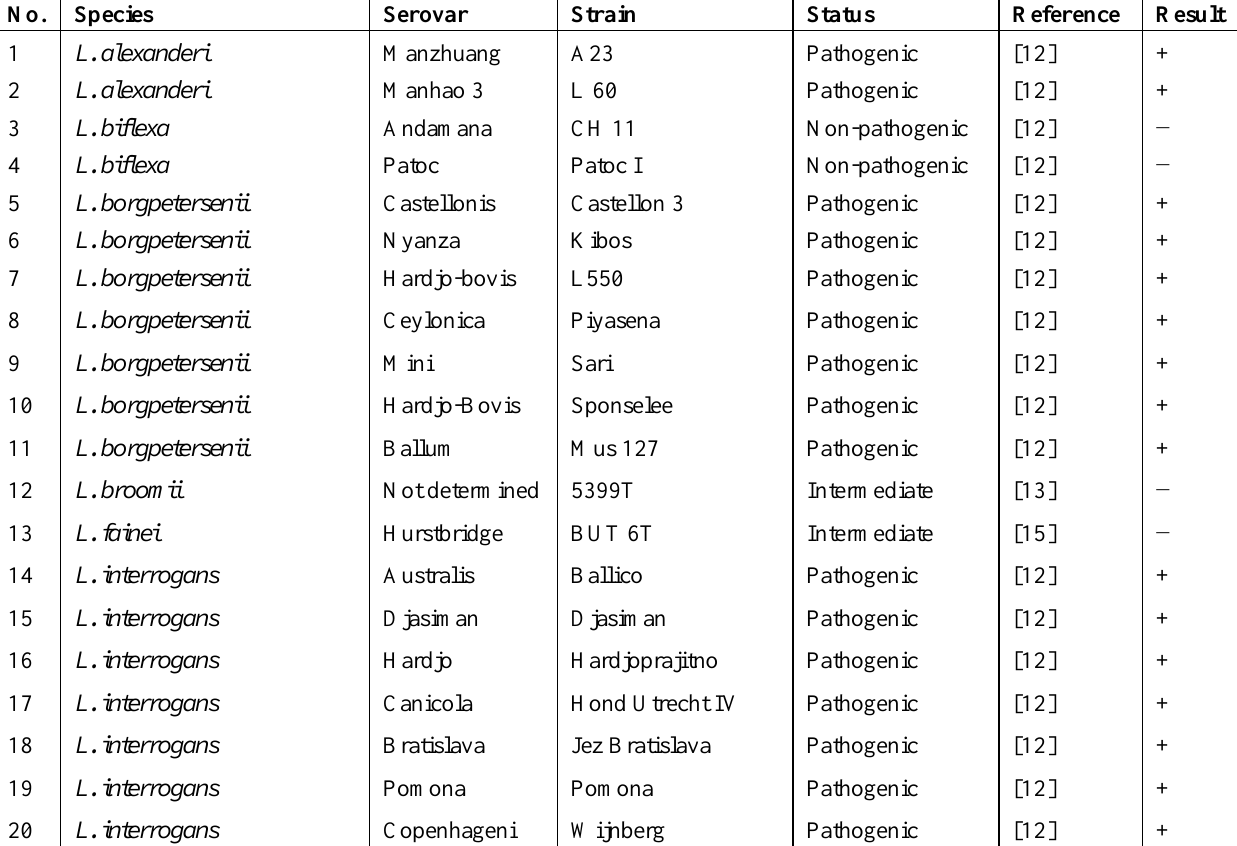
Table 1. Leptospira strains and other microorganism used in this